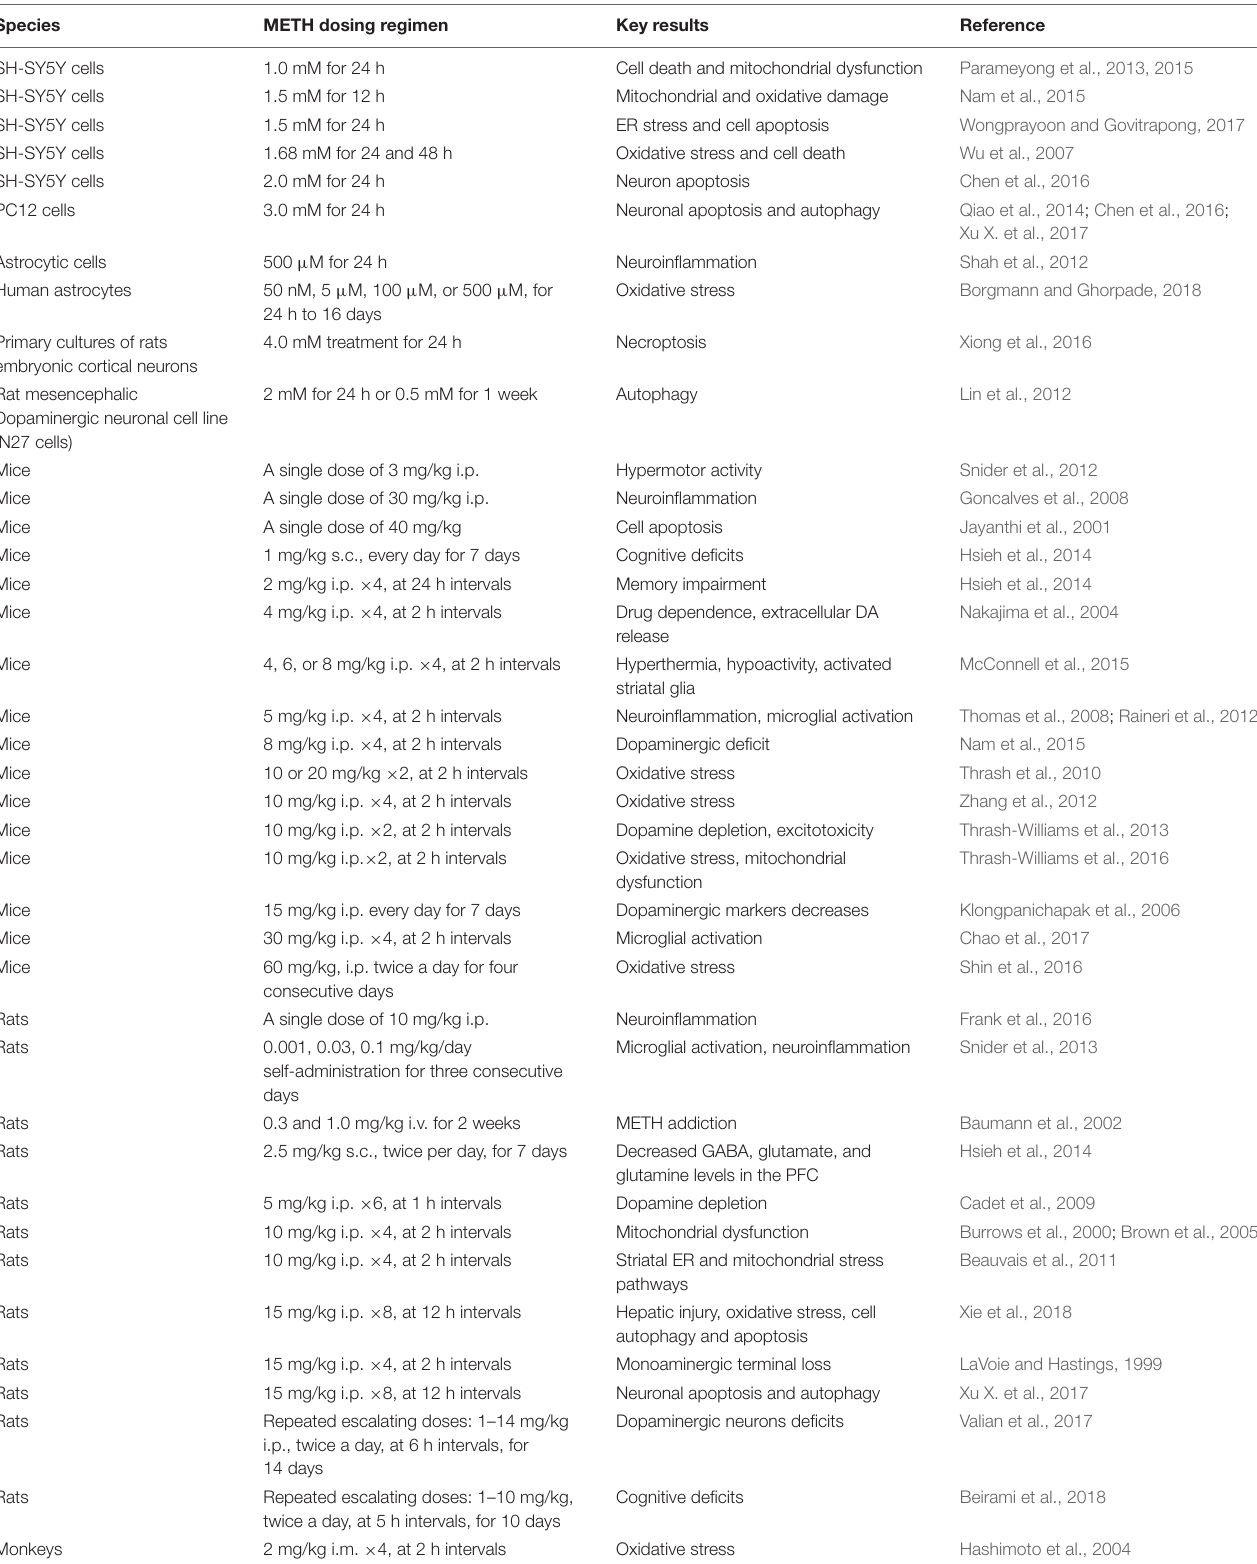
TABLE 1 | The summary of common METH treatment protocols in vivo or in vitro .